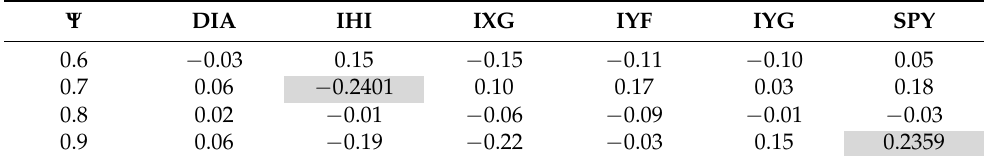
Table 8. Correlation between financial ETFs and VIX for α = 0. Period: January 2014–May 2020. Significant correlations (5% significant level) are highlighted in